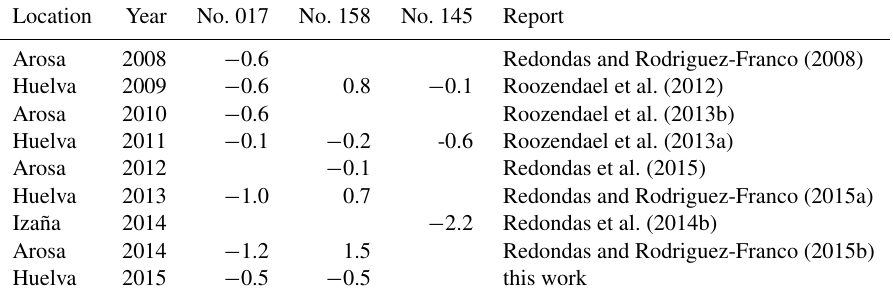
Table 2. Reference comparison during RBCC-E campaigns, the Brewer no. 017 is the travelling reference from International Ozone Ser- vice (IOS), the Brewer no. 158 is the travelling reference from Kipp & Zonen and finally Brewer no. 145 from Environmental Canada is a double Brewer and direct calibrated to the World Reference Triad, which participates on the previous RBCC-E